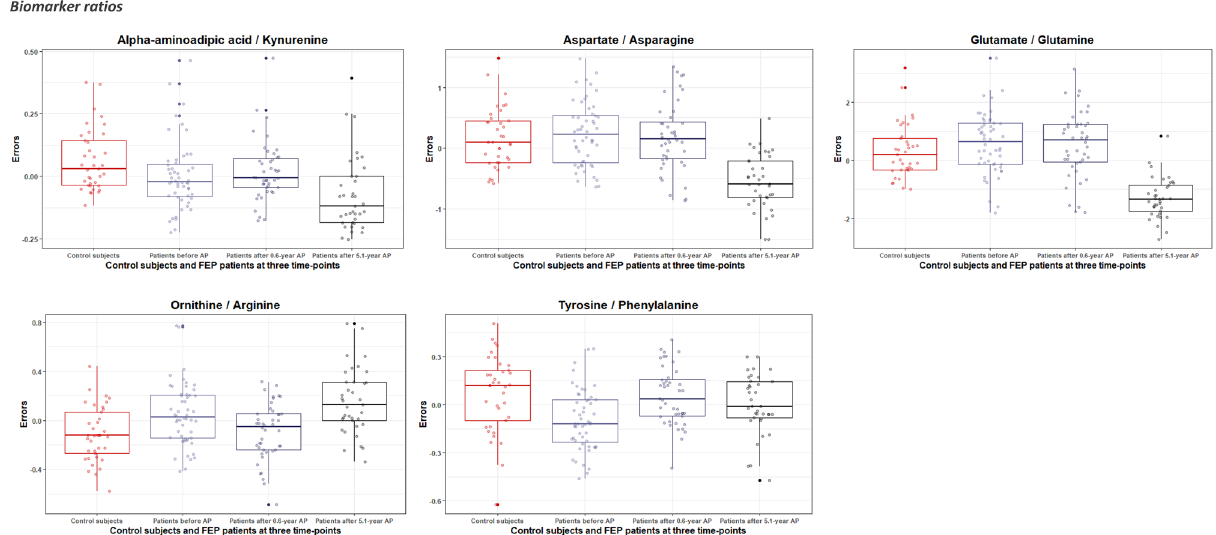
Figure 2. Boxplots of the statistically significant variation of the errors (residuals) of log-transformed biomarker ratios (derived by regressing out covariate effects) for control subjects and first episode (FEP) patients at baseline (before treatment with antipsychotics (AP)), after 0.6-year, and after 5.1-year treatment with AP.